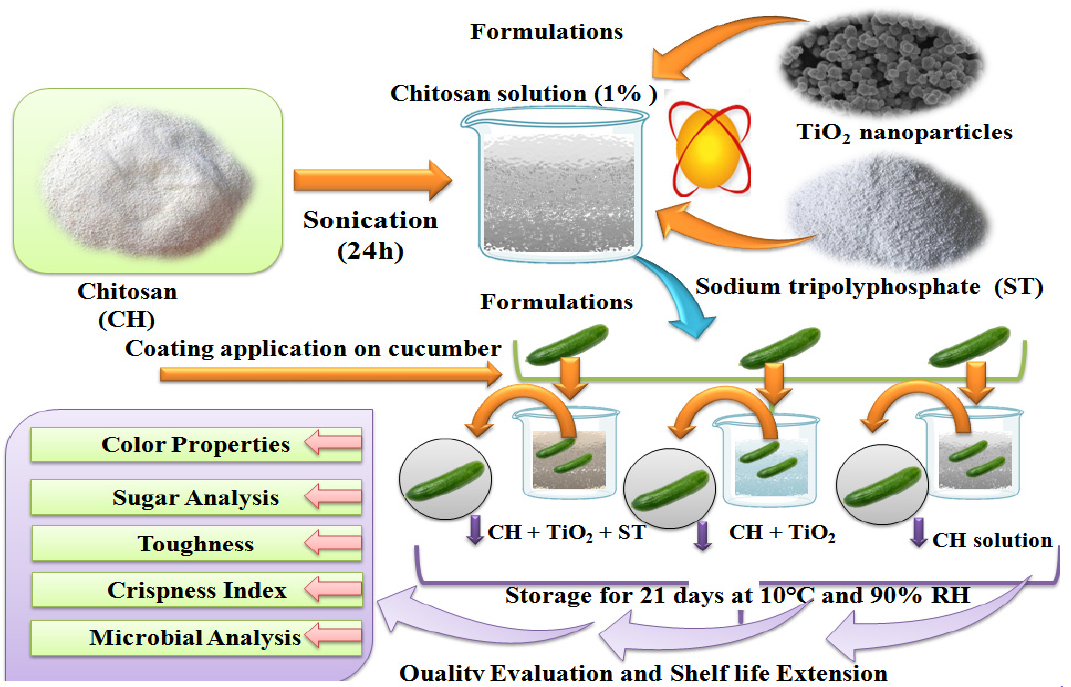
Figure 1. Formulations, coating application on cucumber samples, quality evaluation, and shelf-life extension.